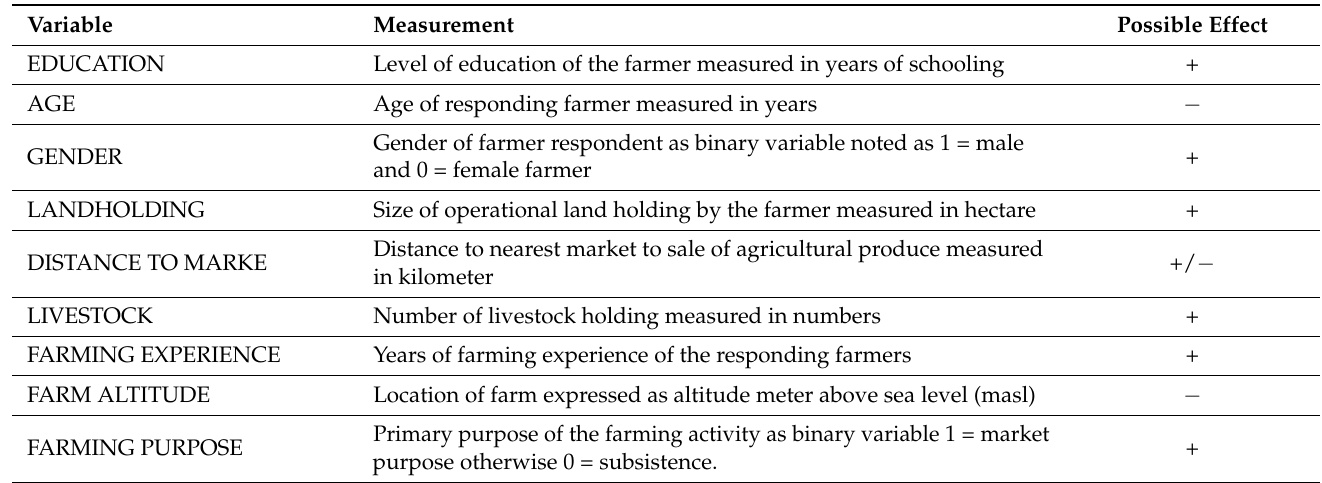
Table 1. Key exogenous variables and their possible effect on the decision.